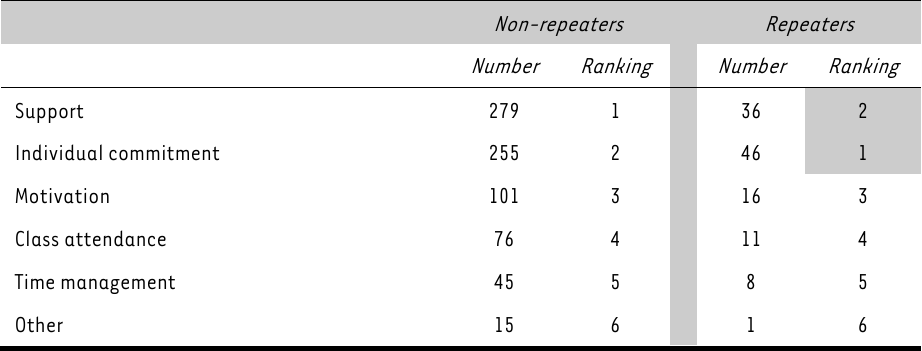
TABLE 5: Factors promoting own success split between repeaters and non-repeaters Non-repeaters Repeaters Number Ranking Number Ranking Support